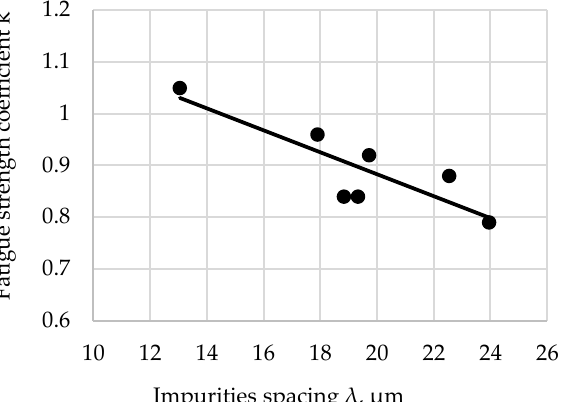
Figure 8. Fatigue strength coefficient, k , of the tested steel after hardening from 880 °C and tempering at 600 °C depends on impurities spacing λ.